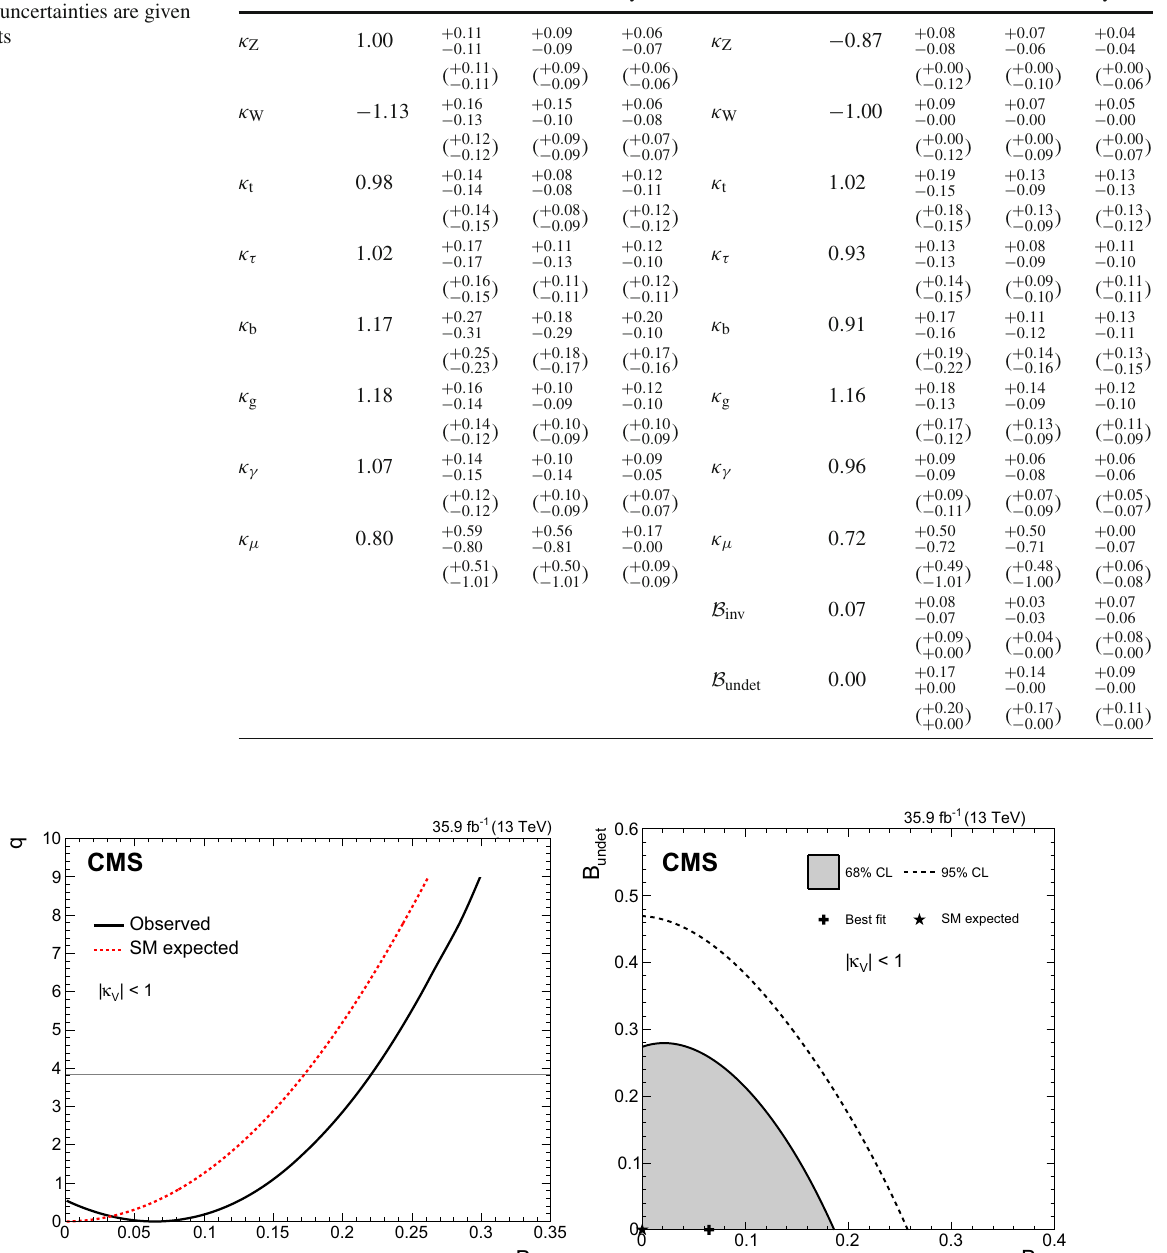
statistic q as a function of B inv (left), and 68 and 95% CL regions for B B inv vs. undet (right). The scan of the test statistic q as a function of B inv expected assuming the SM is also shown in the left